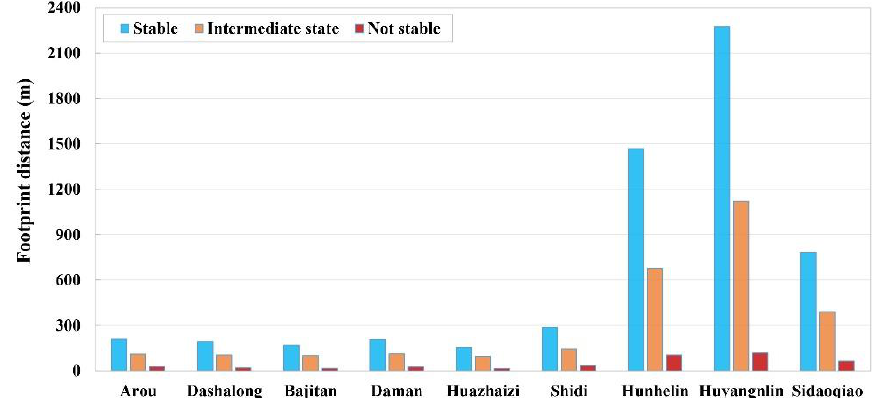
Figure 10. Changes in field GPP footprint with the changes in atmospheric stability.